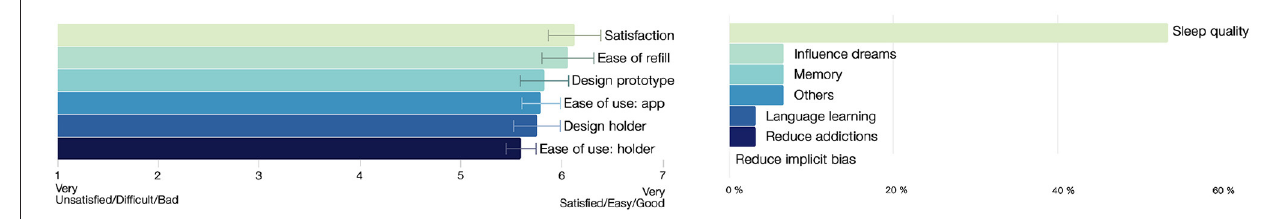
FIGURE 10 | (Left) Usability results for the prototype where 7 is “very positive” and a neutral response is a 4. Satisfaction using the prototype. (Right) Answers from all the participants to the question “What would you prefer to use the prototype